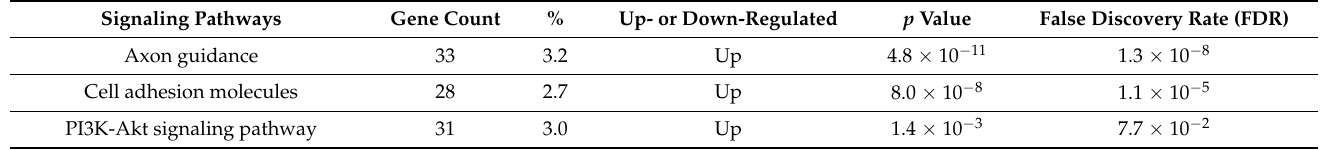
Figure 4. TLR9 deficiency reduced mtDNA and pro-inflammatory cytokine release from lung macrophages. PA enhanced the release of mtDNA ( A ) and neutrophil chemoattractant KC ( B ) from lung macrophages isolated from Cre – (wild-type, WT), but not from Cre + (conditional knockout, CKO) TLR9 floxed mice that were treated oropharyngeally with PA prepared in BSA or BSA (control) for 24 h. Macrophages were cultured without further stimulation in vitro for 24 h before supernatants were collected for mtDNA and KC measurement. n = 5 to 8 mice per group. Table 1. Pathways of genes altered by palmitic acid (vs. BSA control) in wild-type mouse lung